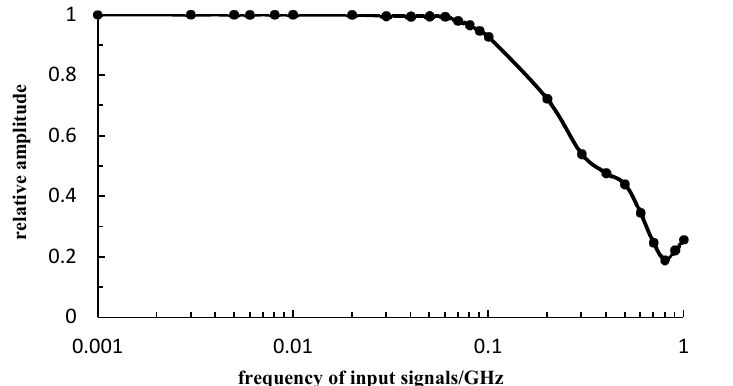
Figure 9. System frequency response.